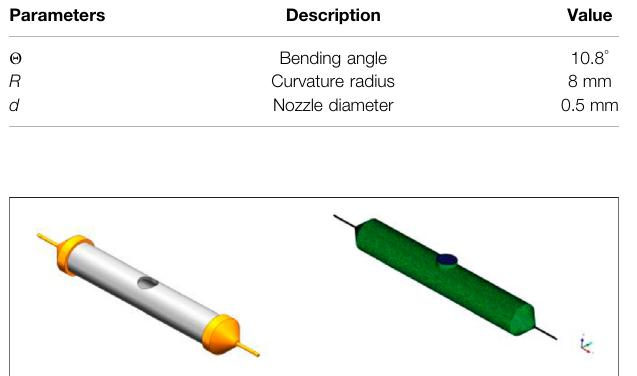
FIGURE 8 | The spinneret model of curved-tube nozzle.